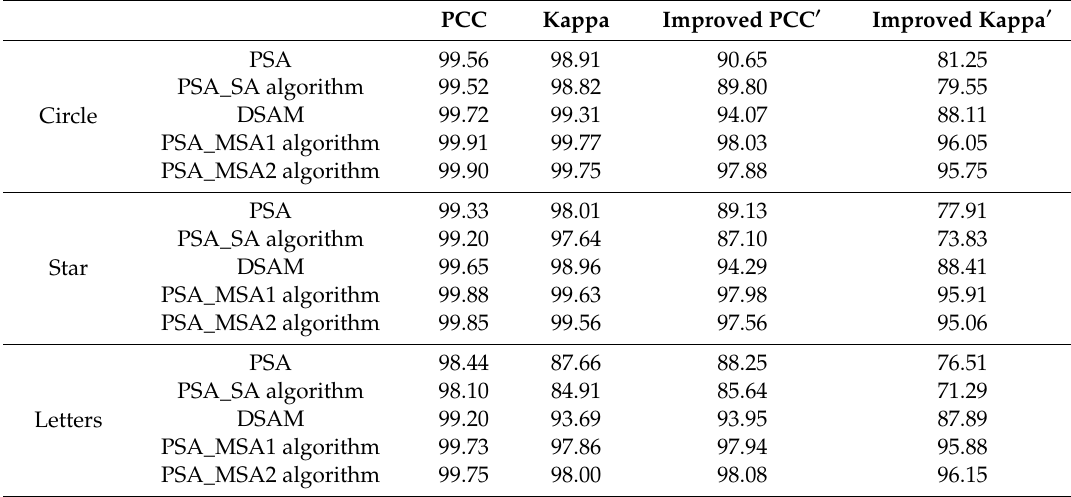
Figure 5. Comparison of the results from different SPM models for artificial shapes at a reconstruction scale of 10: ( a ) the reference image, ( b ) the PSA results, ( c ) the PSA_SA algorithm results, ( d ) the DSAM algorithm results, ( e ) the PSA_MSA1 algorithm results, and ( f ) the PSA_MSA2 algorithm results. Table 1. Accuracy results (%) from different models for images with artificial shapes ( S = 10).